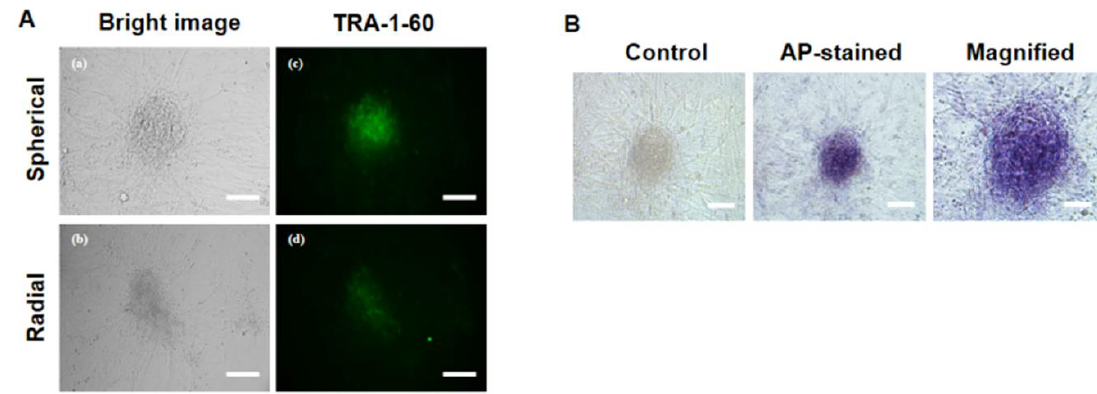
Figure 4. Immunocytochemistry of pluripotency markers in primary canine induced pluripotent stem cell (ciPSC) colonies. ( A ) Expression of the pluripotency marker TRA-1-60 in ciPSCs, as assessed by immunocytochemical analysis. (a) and (c) A spherical colony (No. #4 colony). (b) and (d) A radial colony (No. #2 colony). Scale bars = 50 µ m. ( B ) Image of a spherical domed ciPSC colony (No. #4 colony) after introducing four factors ( VEE-hOct4 , VEE-hKlf4 , VEE-hSox2 , and VEE-hGlis1 ) by mRNA transfection on day 27 (left); scale bars = 200 µ m. Representative image of an AP-positive colony (middle); scale bars = 200 µ m. Magnified image of an AP-positive colony (right); scale bars = 50 µ m. The radial colonies were subcultured and maintained well on the feeder layers. When the radial